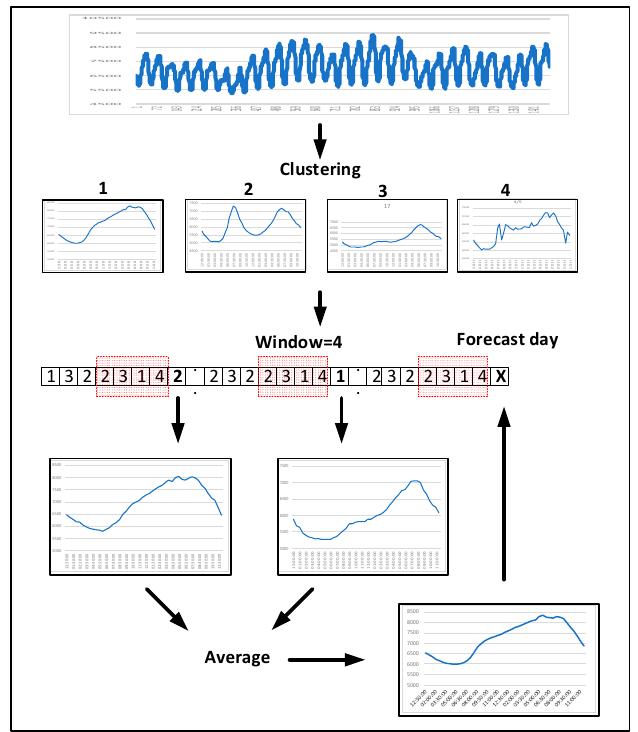
Figure 5. Schematic diagram of pattern sequence-based forecasting method [26].